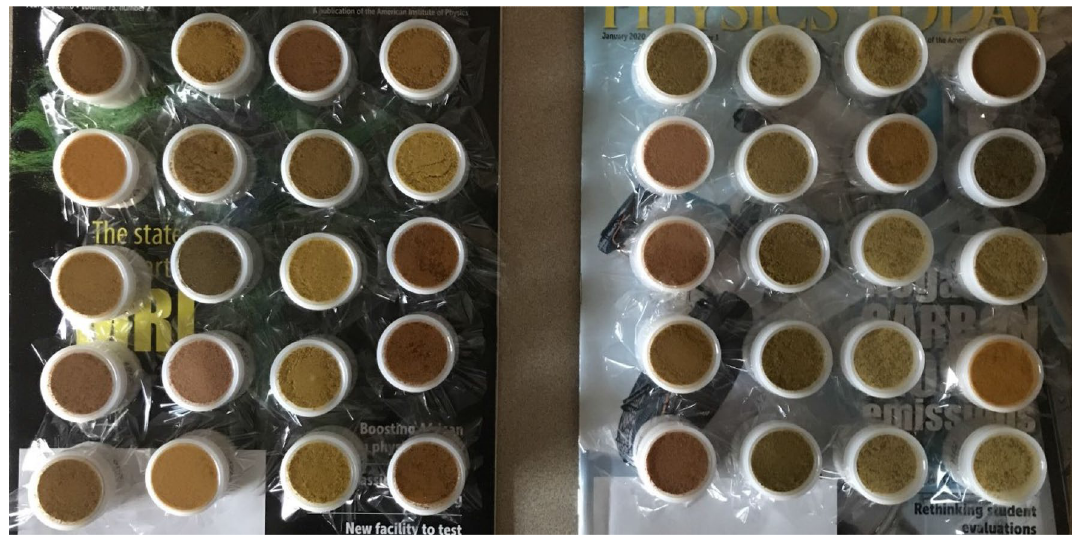
Fig. 2 The complete collection of 40 powder spice samples in sample